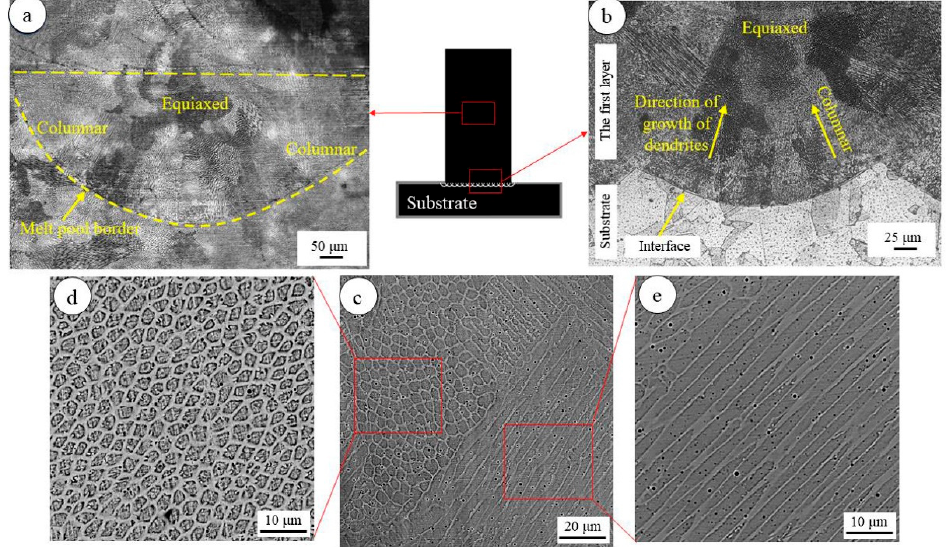
Figure 4. Light optical microscopy micrographs of the DED AISI 316L steel samples produced by DED: ( a ) a representative melt pool at the middle height, ( b ) the microstructure of the first layer, ( c ) SEM images of the columnar and equiaxed microstructures referring to the last deposited layer, ( d , e ) high magnifications of ( c ) from two different regions [37].